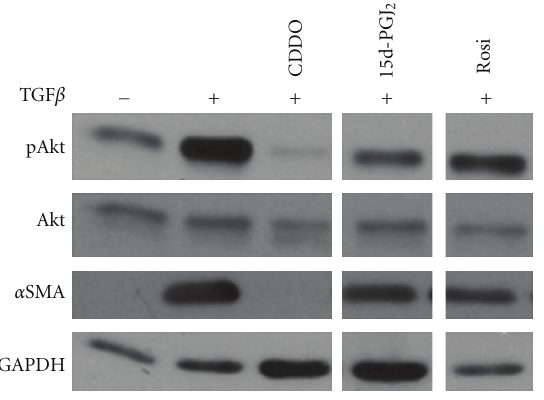
Figure 2: PPAR γ ligands inhibit TGF β -induced Akt phosphoryla- tion and myofibroblast di ff erentiation with varied potency. Primary human lung fibroblasts were treated with TGF β (5ng/mL), alone or in combination with three PPAR γ ligands (CDDO (1 μ M), 15d- PGJ 2 (5 μ M) and rosiglitazone (20 μ M)). Protein lysates were elec- trophoretically separated on the same gel, and representative lanes from a single experiment are shown here. The potency of a PPAR γ ligand to inhibit Akt phosphorylation corresponds to its ability to inhibit myofibroblast di ff erentiation. While CDDO inhibits both Akt phosphorylation and α SMA potently, rosiglitazone is a weak inhibitor of